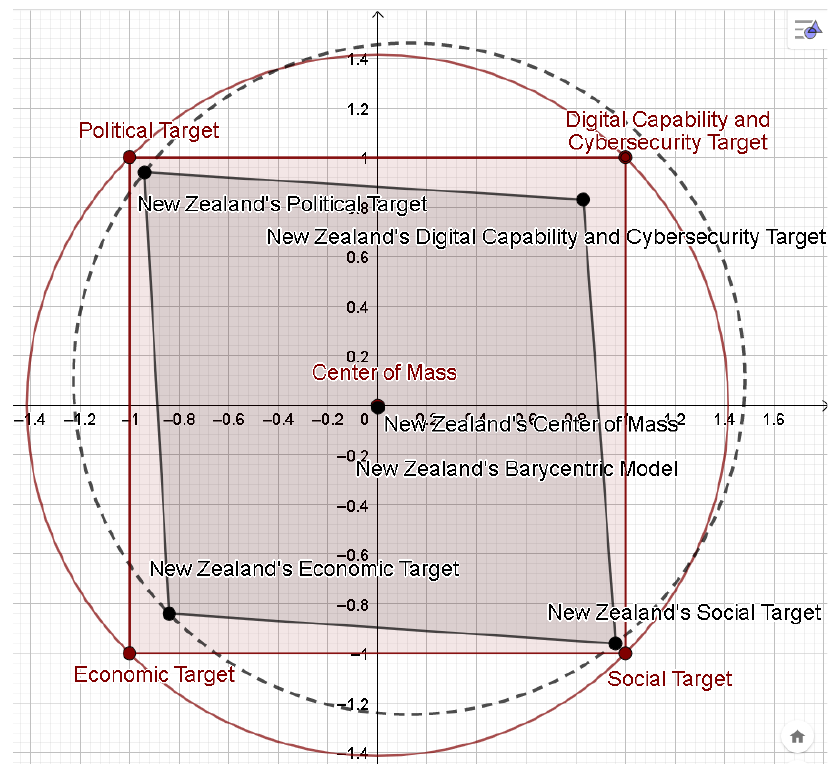
Figure 11. Four–pole barycentric model of balanced development of New Zealand. Source: Authors’